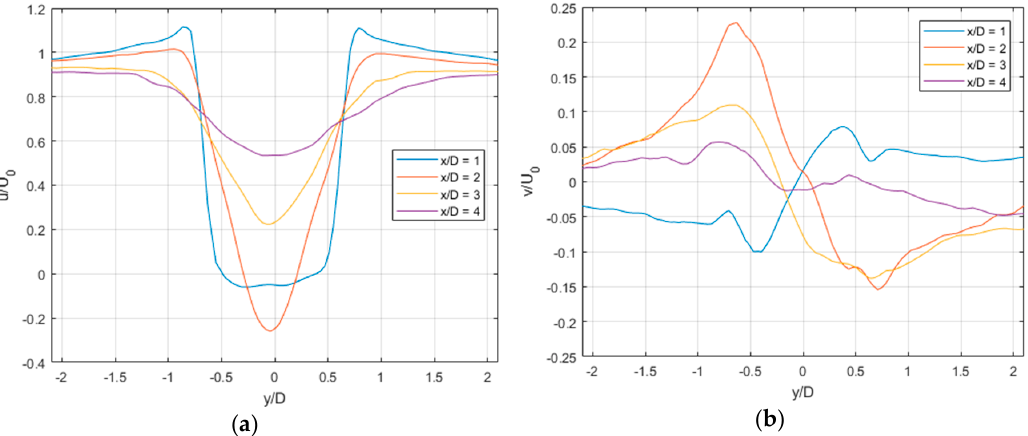
Figure 3. Velocity profiles (y-direction) at selected points downstream. ( a ) x-component, ( b ) y-component.